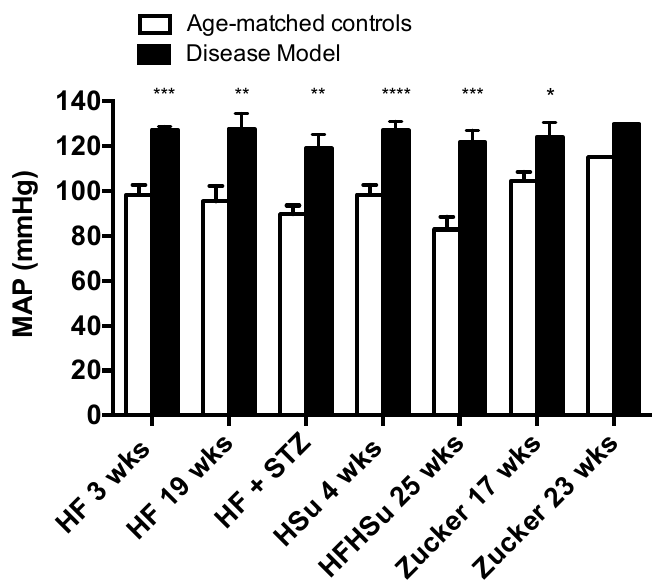
Figure 4. Mean arterial pressure levels in the distinct models of obesity and type 2 diabetes. All groups of hypercaloric diet animals and its aged-matched controls as well as Zucker diabetic rat and its lean controls of 17 weeks included 6–8 animals per group; Zucker diabetic rat of 23 weeks included 3 animals per group, and its lean control only one animal. Bars represent means ± SEM; two-way ANOVA with Bonferroni’s multiple comparisons test: * p < 0.05, ** p < 0.01, *** p < 0.001, and **** p < 0.0001 comparing age-matched controls with disease models.